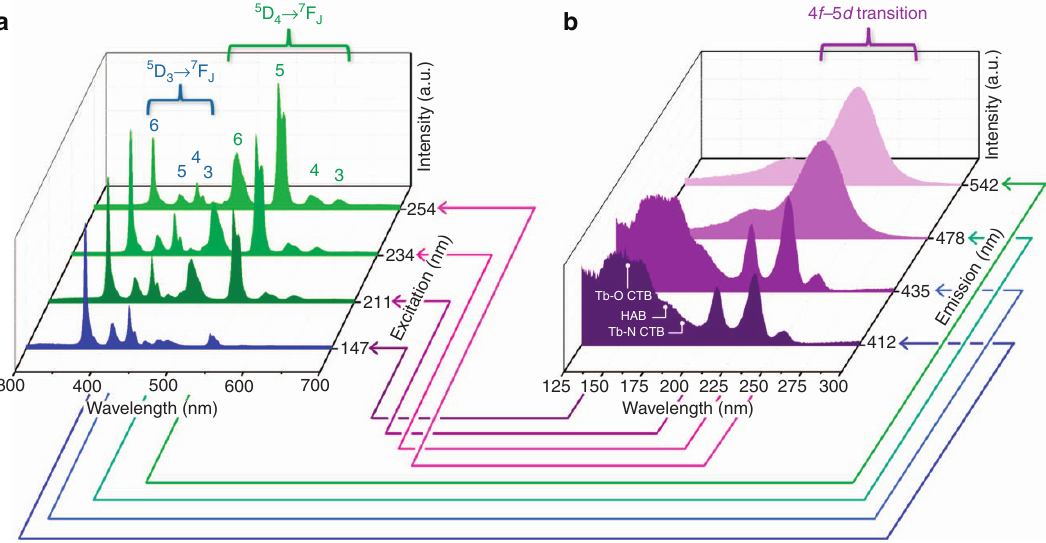
Figure 2 Synchrotron photoluminescence of the Ba 2.89 Si 6 O 12 N 2 :Tb 0.11 material. ( a ) Emission spectra from synchrotron radiation excited by different wavelengths and ( b ) excitation spectra monitored at 5 D 3 and 5 D 4 transition sets at room temperature. The arrows illustrate the excited or monitored wavelengths from speci fi c positions of the excitation or emission spectra,